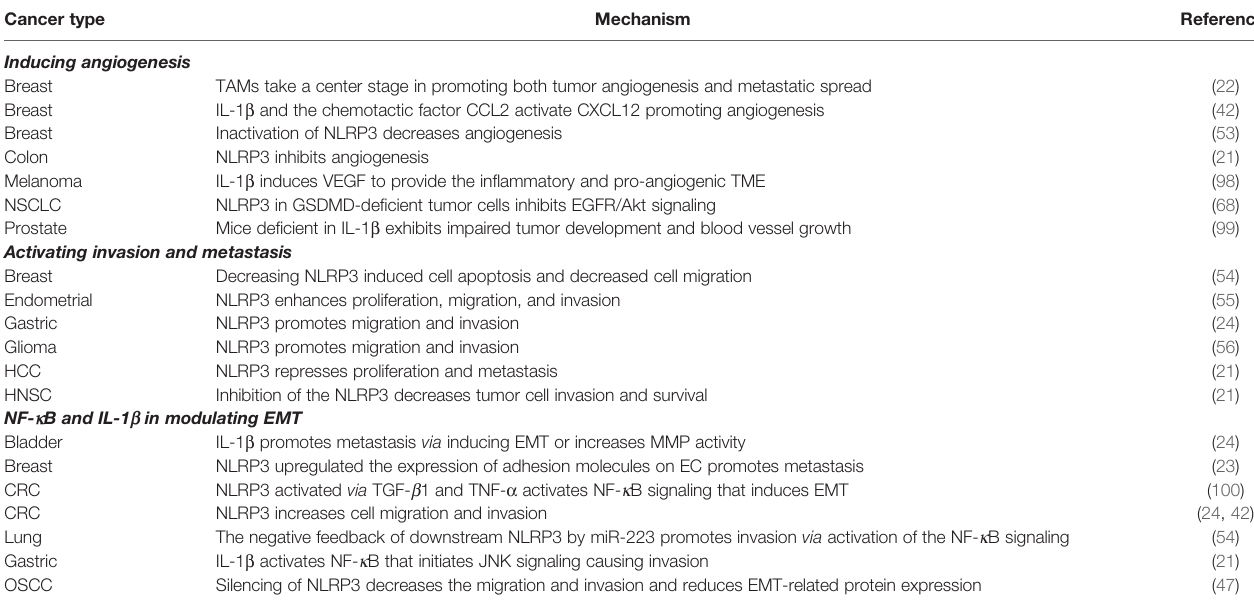
TABLE 4 | Metastasis-associated cancer